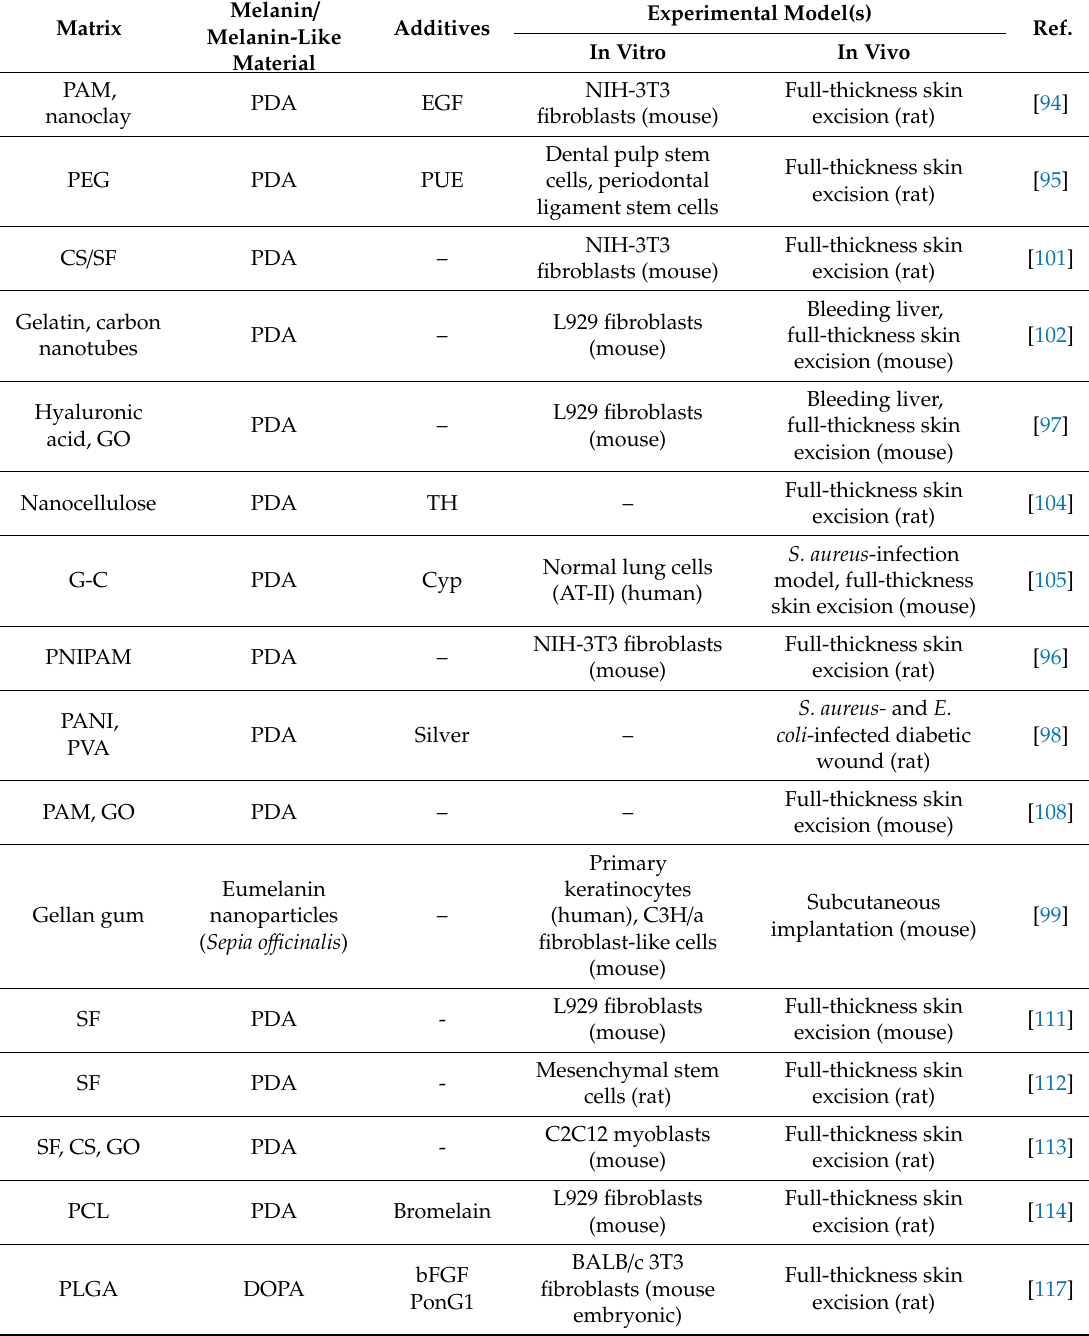
Table 2. Summary of melanins / melanin-like materials for wound healing.